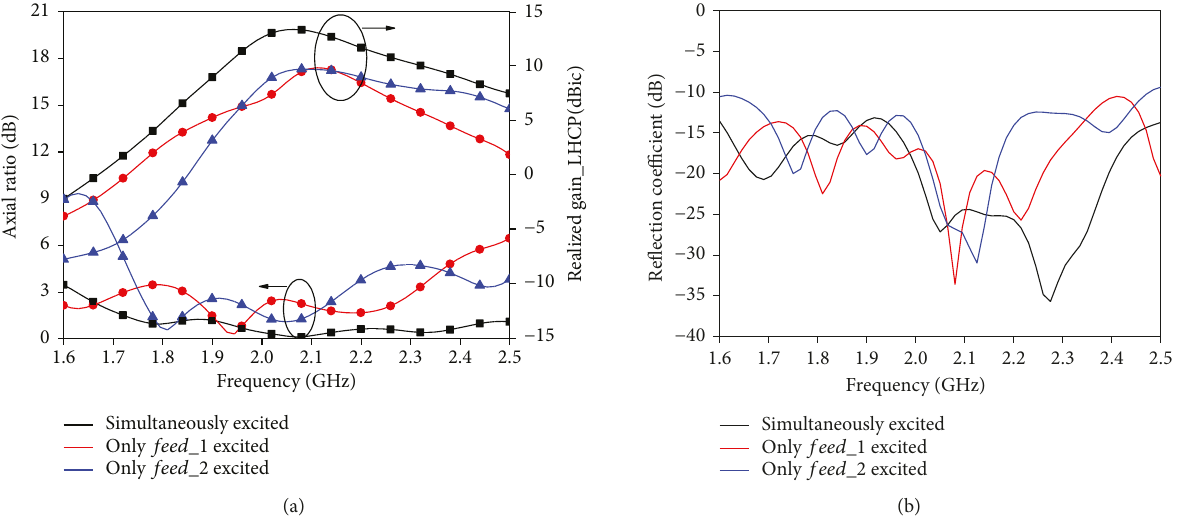
Figure 8: E ff ects of di ff erent excitation modes for the array. (a) Realized gain and axial ratio. (b) Re fl ection coe ffi cient.